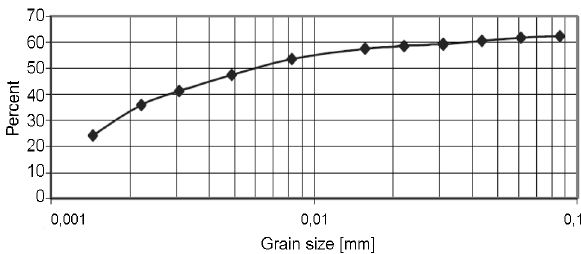
Fig. 5. Average size distribution of eight soil samples from test site